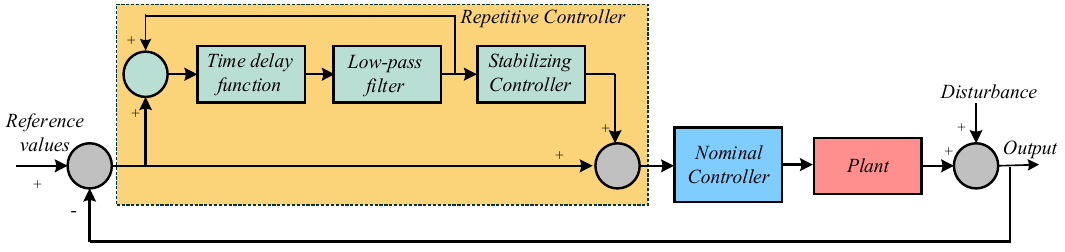
Figure 27. Block diagram of Repetitive control algorithm.